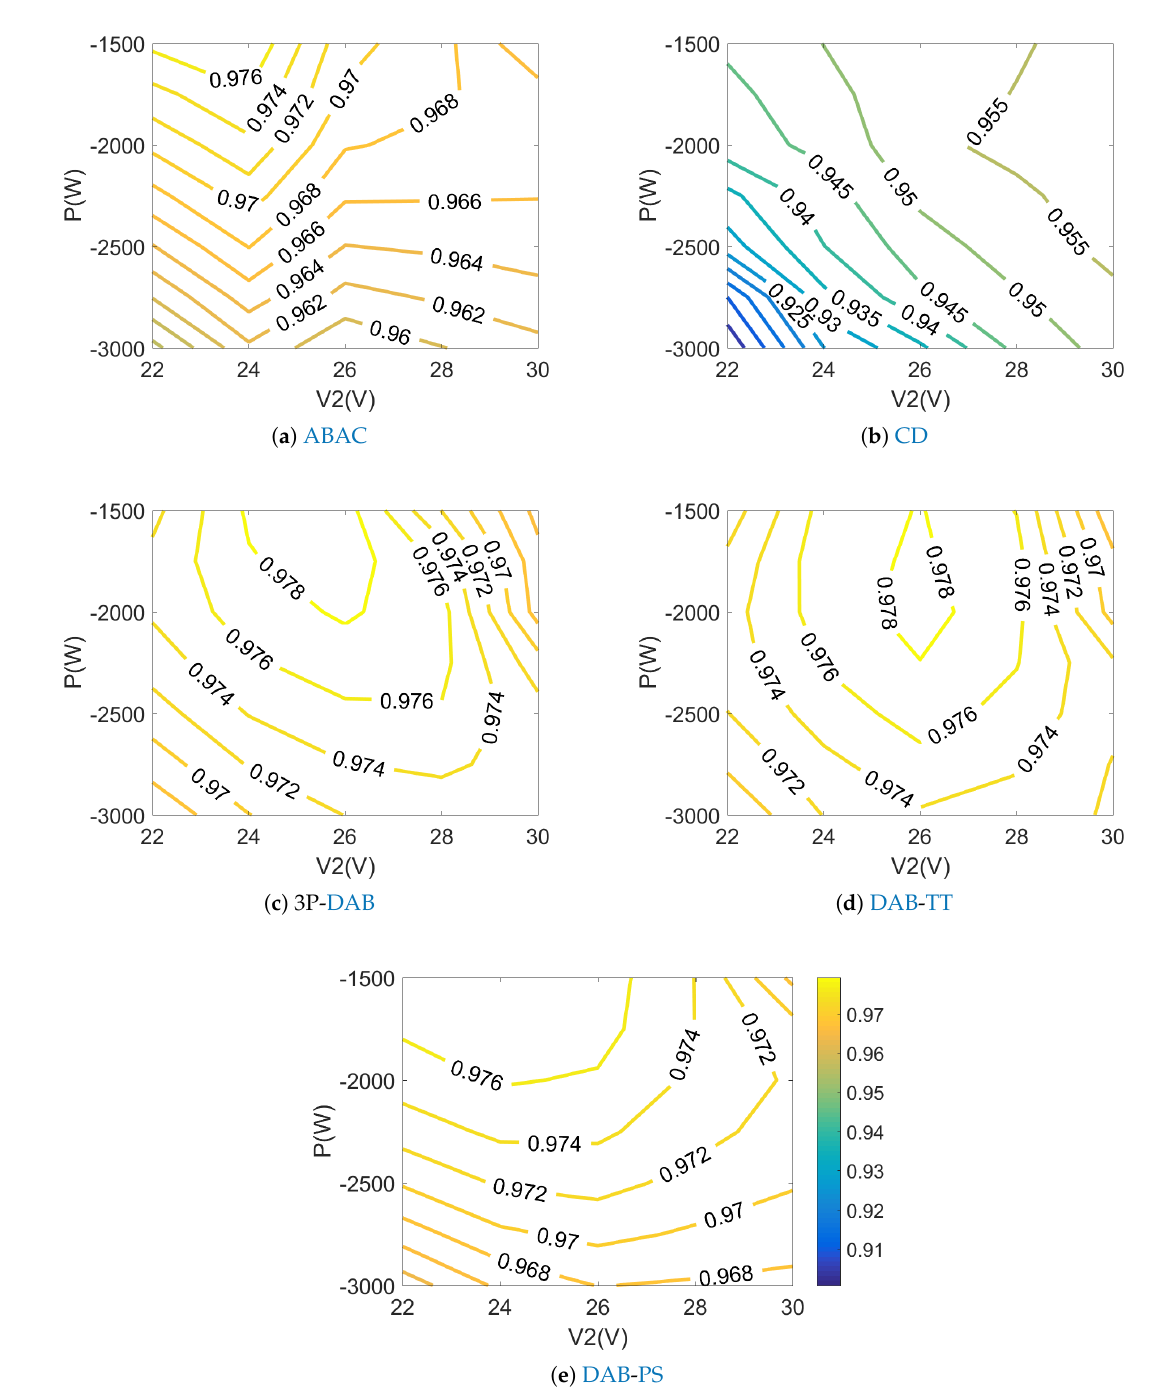
Figure 10. Efficiency map in boost mode, from half power to full power, wide V2 input range, and nominal